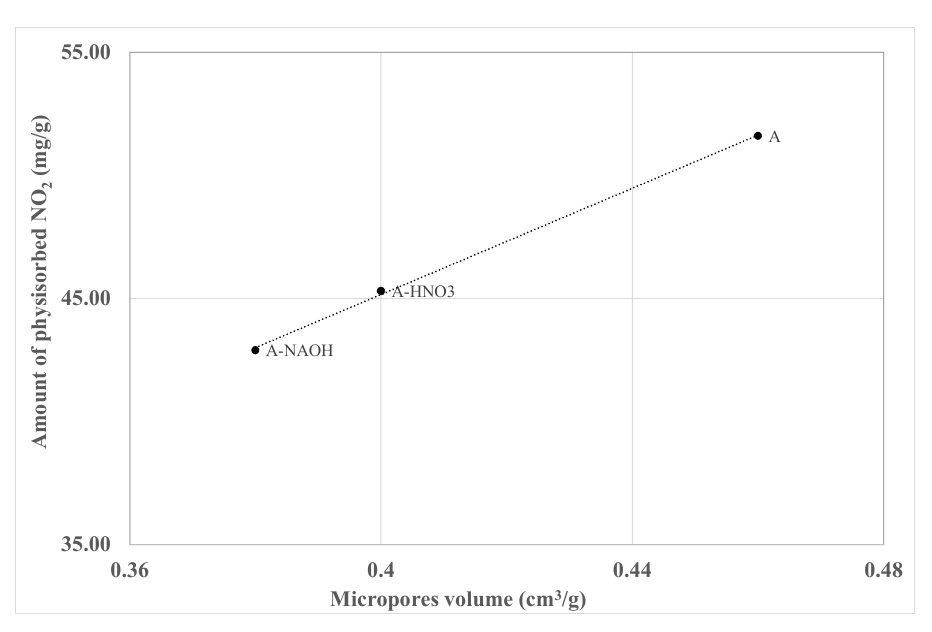
Figure 14 . Correlation between the micropores volume and the amount of physisorbed NO 2 on the different activated carbons.